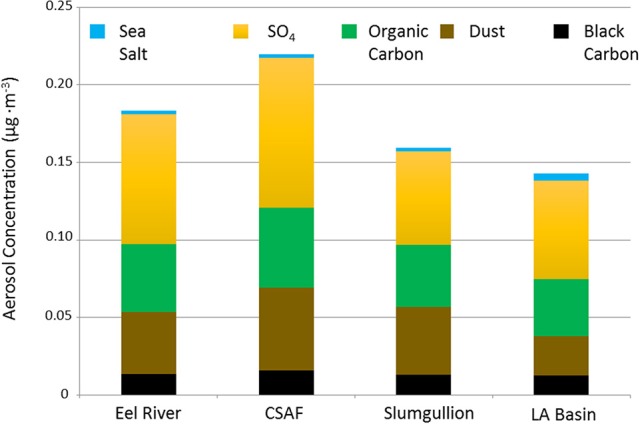
MERRA-2 data summarizing SO4, organic carbon, dust, black carbon, and sea salt aerosol concentrations averaged across the cruise altitude of ~12 km for each flight.